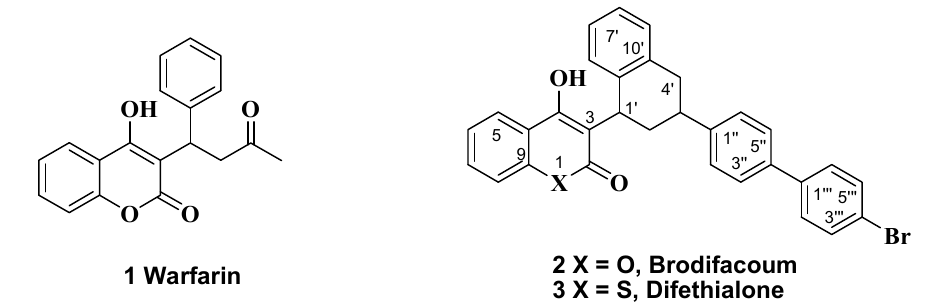
Figure 1. Structures of warfarin ( 1 ), brodifacoum ( 2 ), and difethialone ( 3